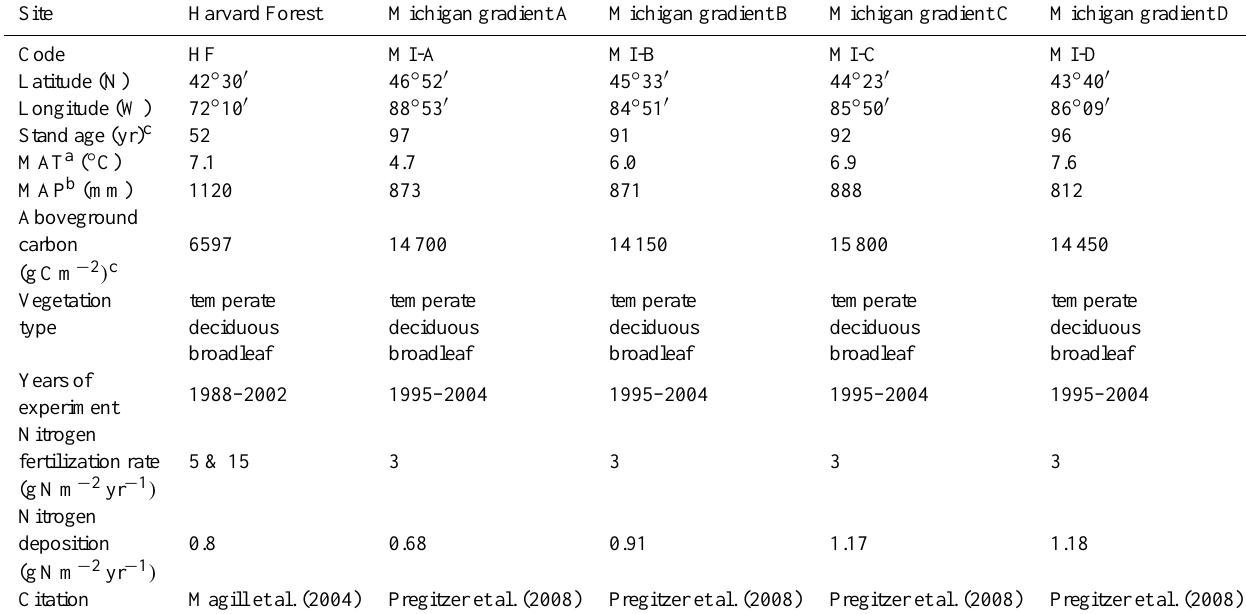
Table 1. Descriptions of sites used in model